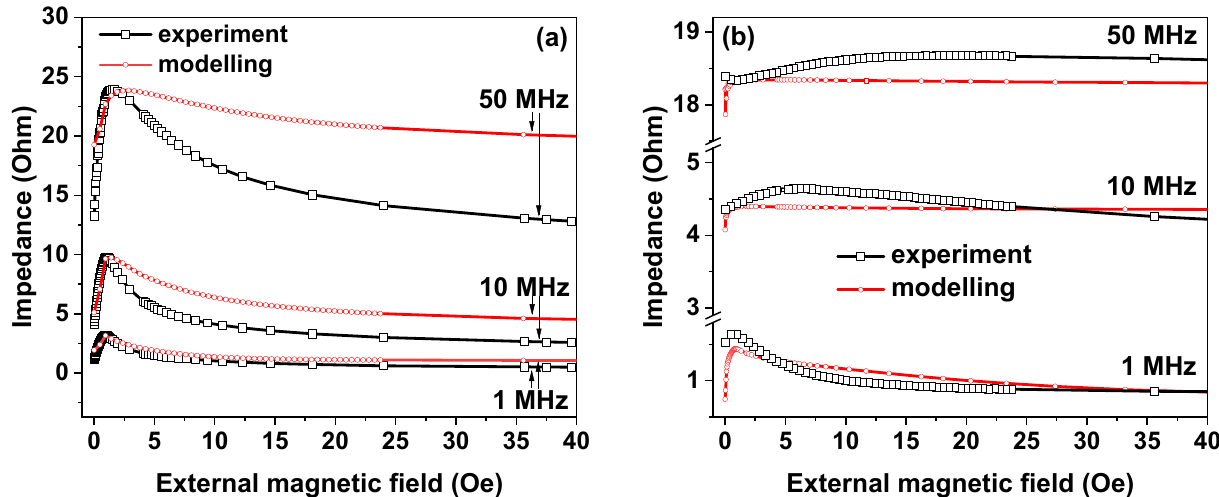
Figure 4. Difference between the experimental field dependence of the total impedance value and the same parameter obtained by the computer simulation: ( a ) for the IR ( b ) for the R-FeNi samples with a thickness of FeNi equal to 1 µ m.